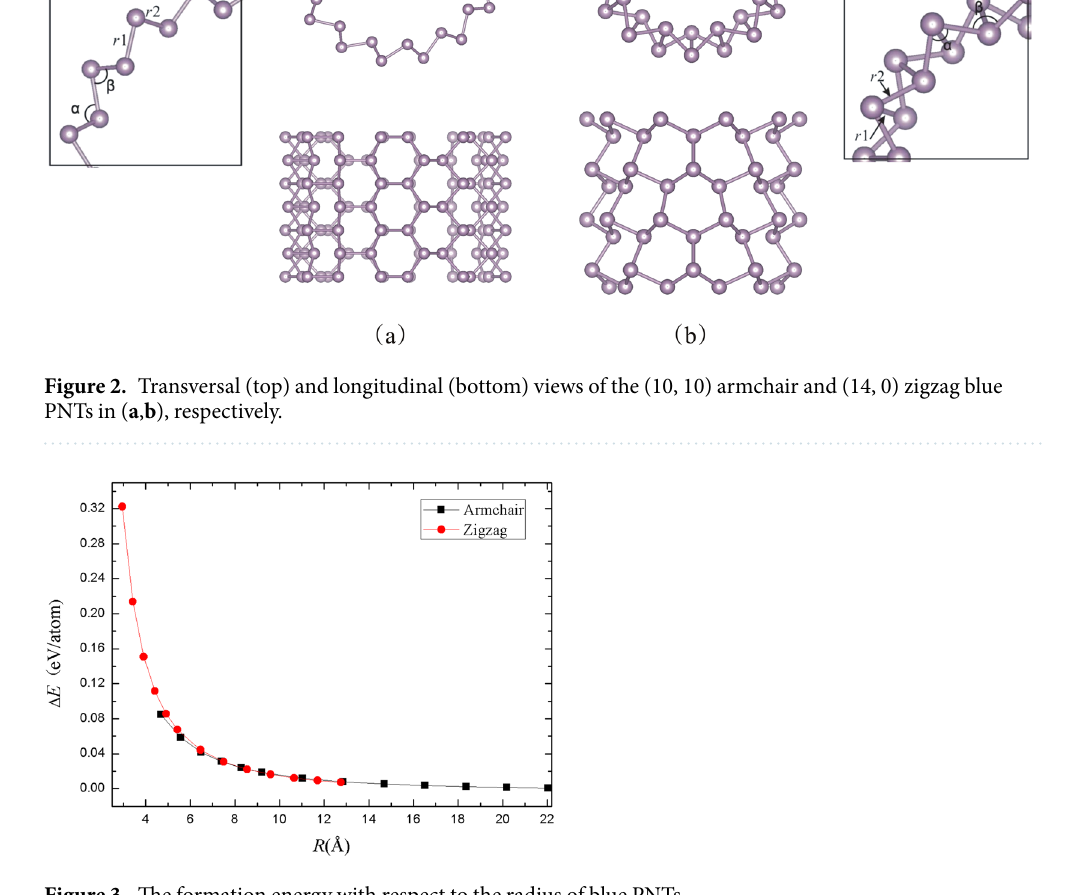
Figure 3. The formation energy with respect to the radius of blue